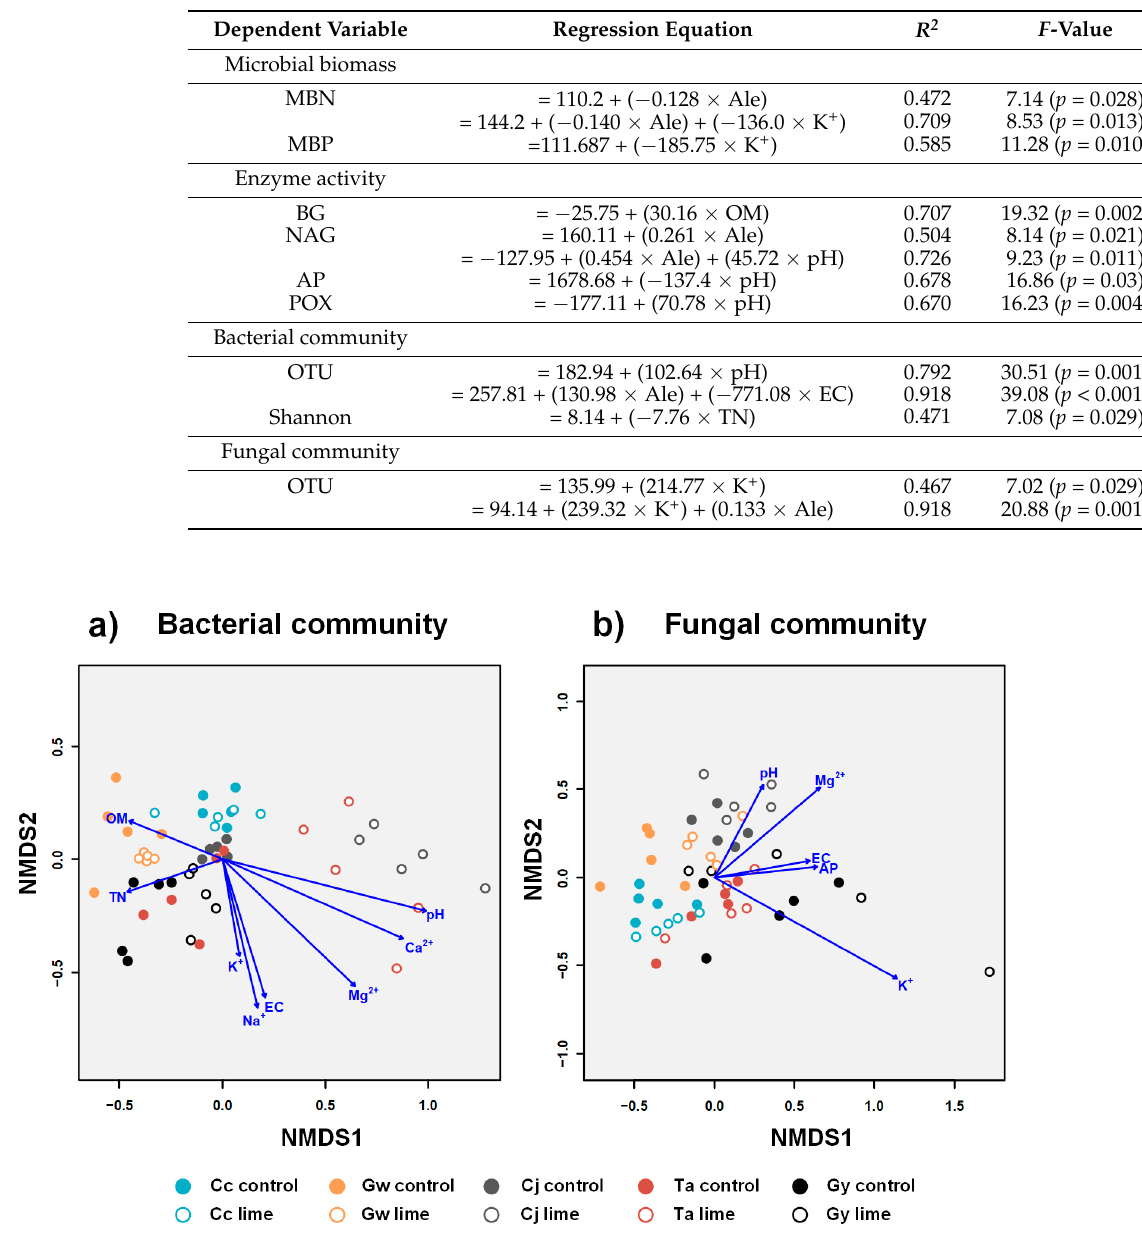
Figure 4. Nonmetric multidimensional scaling ordination between the species composition and relative abundances of ( a ) the bacterial community and ( b ) fungal phyla and soil chemical properties. Arrow directions indicate the correlation slopes, and arrow lengths indicate the degrees of influence of the various factors. Table 4. Stepwise multiple regression analysis of soil microbial biomass, extracellular enzyme activity, microbial community index, and selected soil parameters from nonmetric multidimen- sional scaling (NMDS).